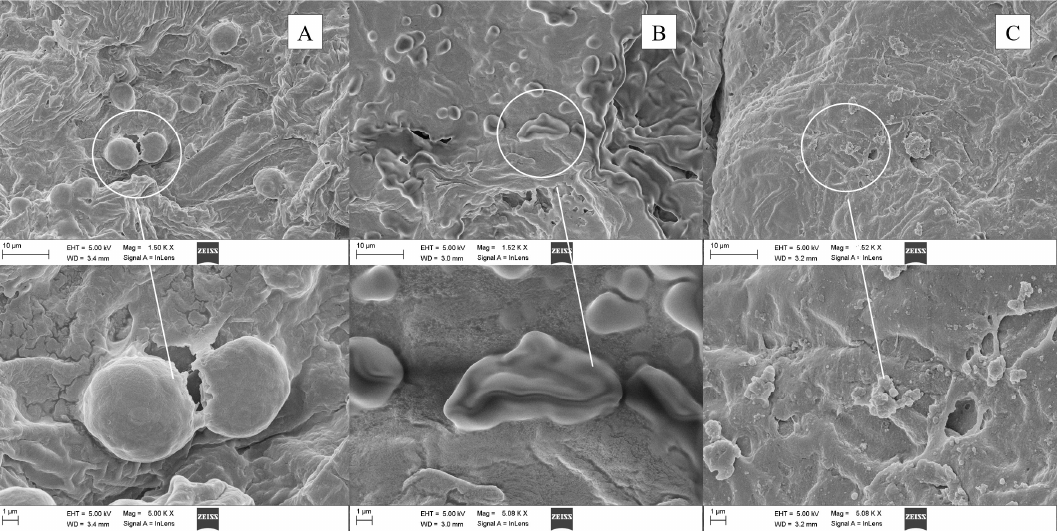
Figure 5. The upper epidermis of L. cubeba fresh fruits observed by SEM: ( A ) before extraction; ( B ) after hydrodistillation; and ( C ) after solvent-free microwave extraction.